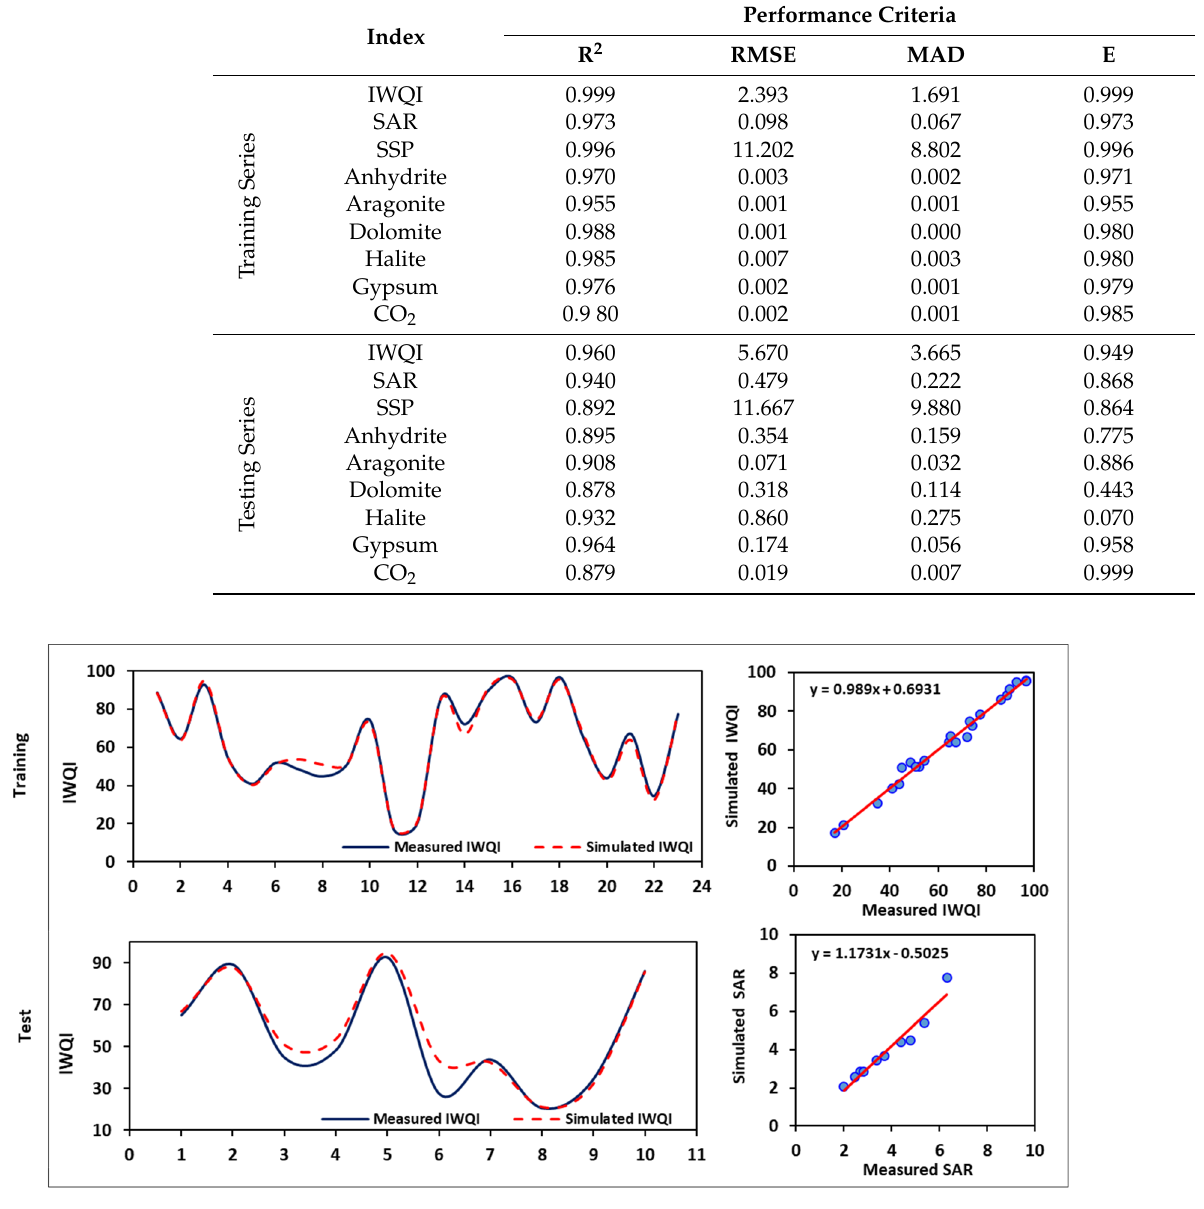
Table 7. Performance criteria of the simulation models for IWQIs prediction.